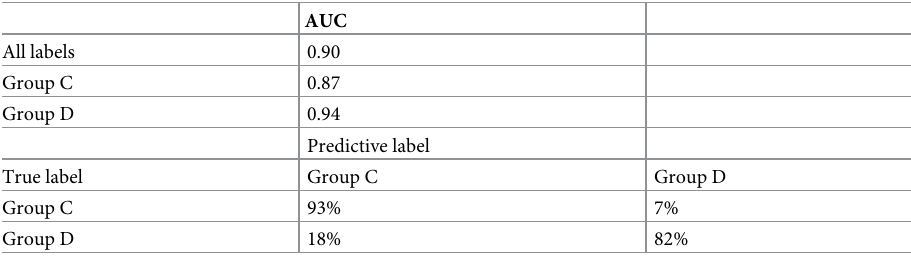
Table 3. Groups C and D model of the colon; AUC and confusion